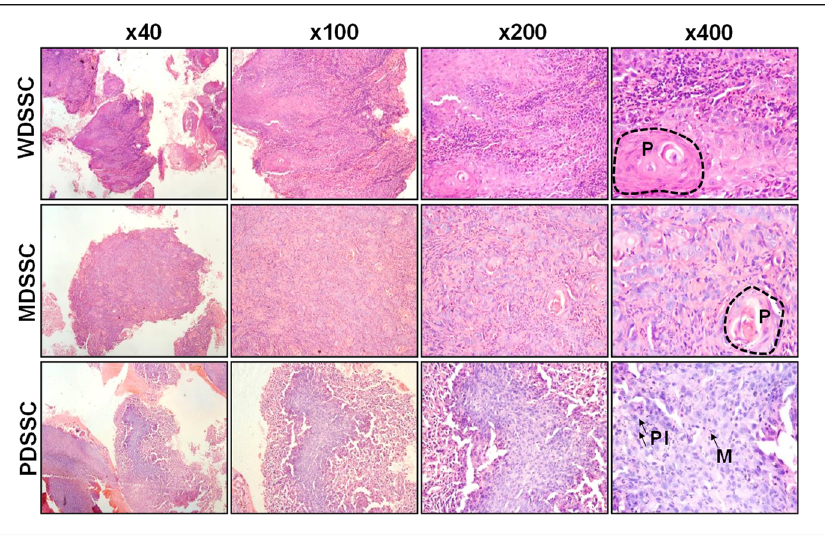
Figure 1. Representative images of hematoxylin and eosin (H & E) stained oral squamous cell carcinoma at x40, x100, x200, and x400 magnification. Well-differentiated squamous cell carcinoma (WDSCC) and moderately differentiated squamous cell carcinoma (MDSCC) showing large and small keratin pearls (P), respectively. Poorly differentiated squamous cell carcinoma (PDSCC) showing mitosis (M) and pleomorphism (Pl). Table 1. Clinicopathologic characteristics of oral squamous cell carcinoma (OSCC) patients.